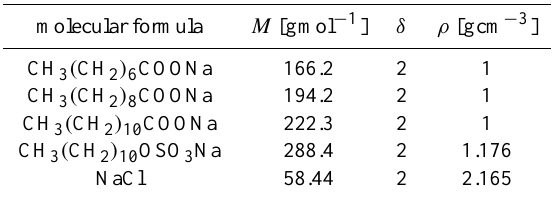
Table 2. Physical properties of the studied compounds used in model calculations: molar mass M [gmol − 1 ], dissociation factor δ , and bulk mass-density ρ [gcm − 3 ]. In all cases we have assumed δ = 2, and for the fatty acid salts we assumed ρ FAS = 1gcm − 3